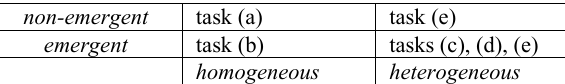
Table 1. emergent : the value is derived from the entirety of contributions / non-emergent : it is derived directly from each contribution / homogeneous : contributions are seen as qualitatively identical / heterogeneous : contributions are valued differently according to their individual